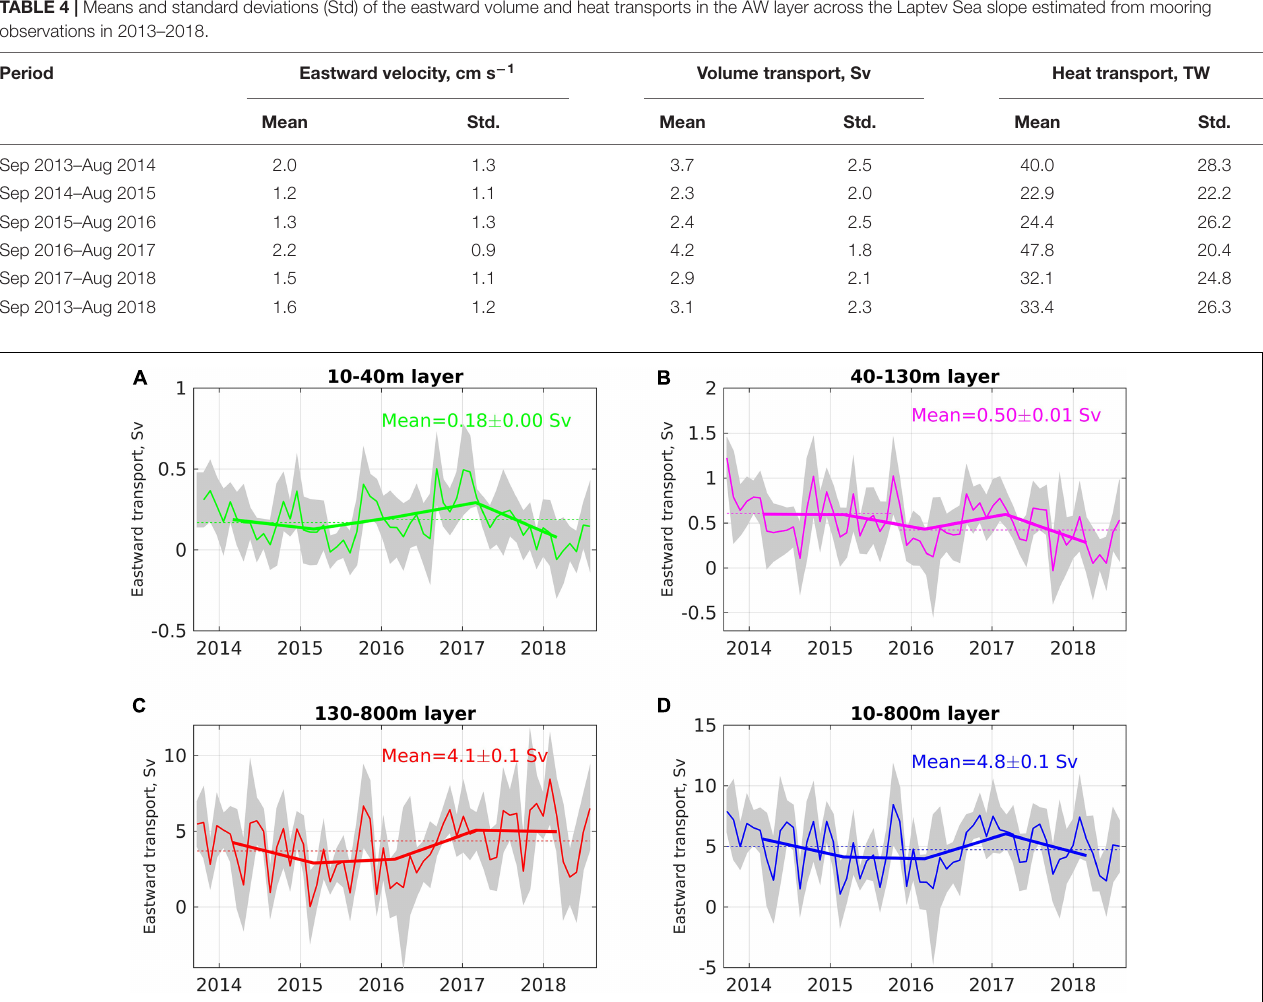
FIGURE 4 | Monthly net volume transport across the Laptev Sea slope (A) in the 10–40 m, (B) 40–130 m, (C) 130–80 m, and (D) in the upper 800-m